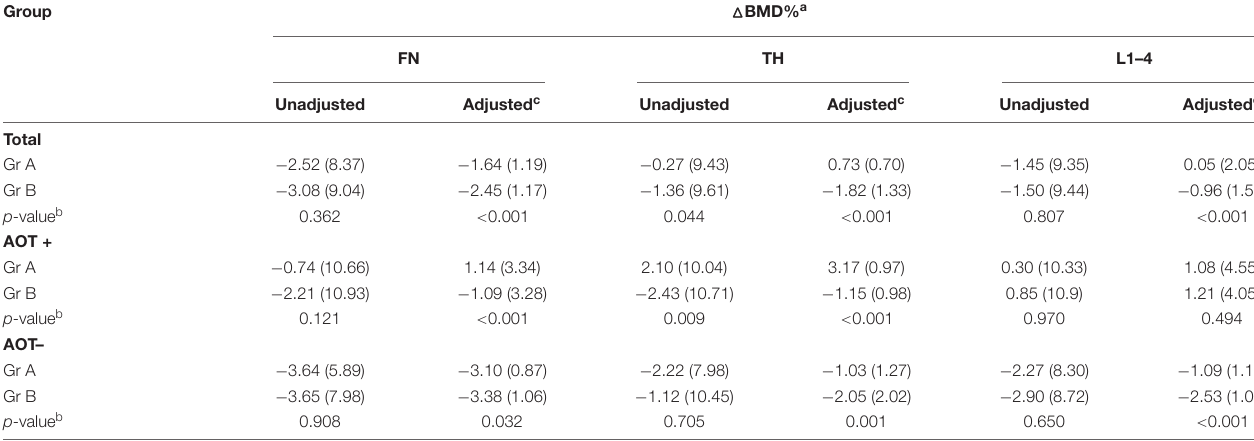
TABLE 3 | Regression-adjusted percentage change in BMD from baseline in each group, after matching.